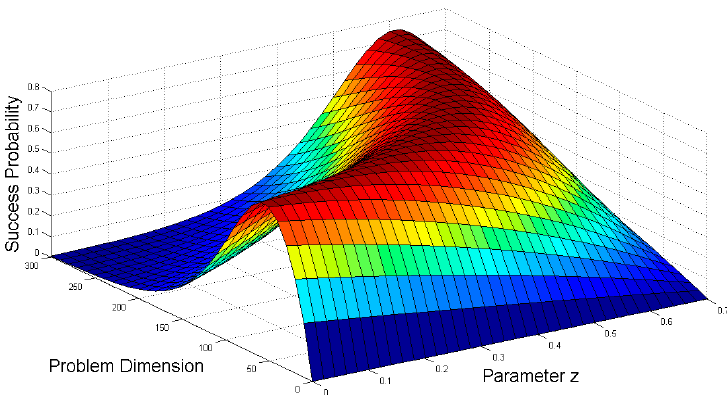
Figure 4. Influence of parameter z on the success probability of the proposed algorithm in various problem dimensions ( q 0 = 98.0 ).